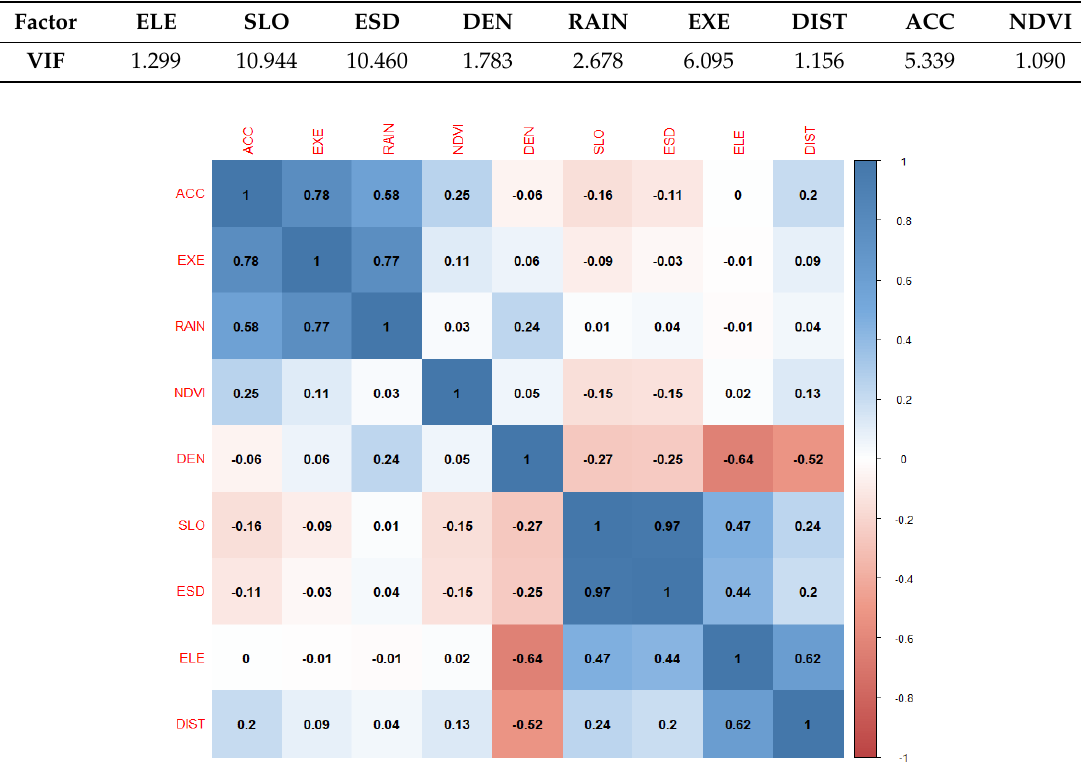
Table 3. Variance inflation factor.